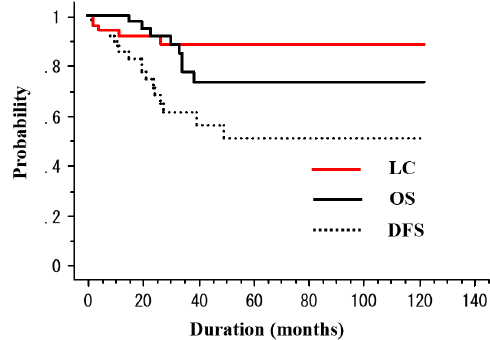
Figure 1. The overall survival (OS), disease ‐ free survival (DFS), and local control (LC) rates for patients with T1N0M0 esophageal cancer treated with radiotherapy. P = 0.02